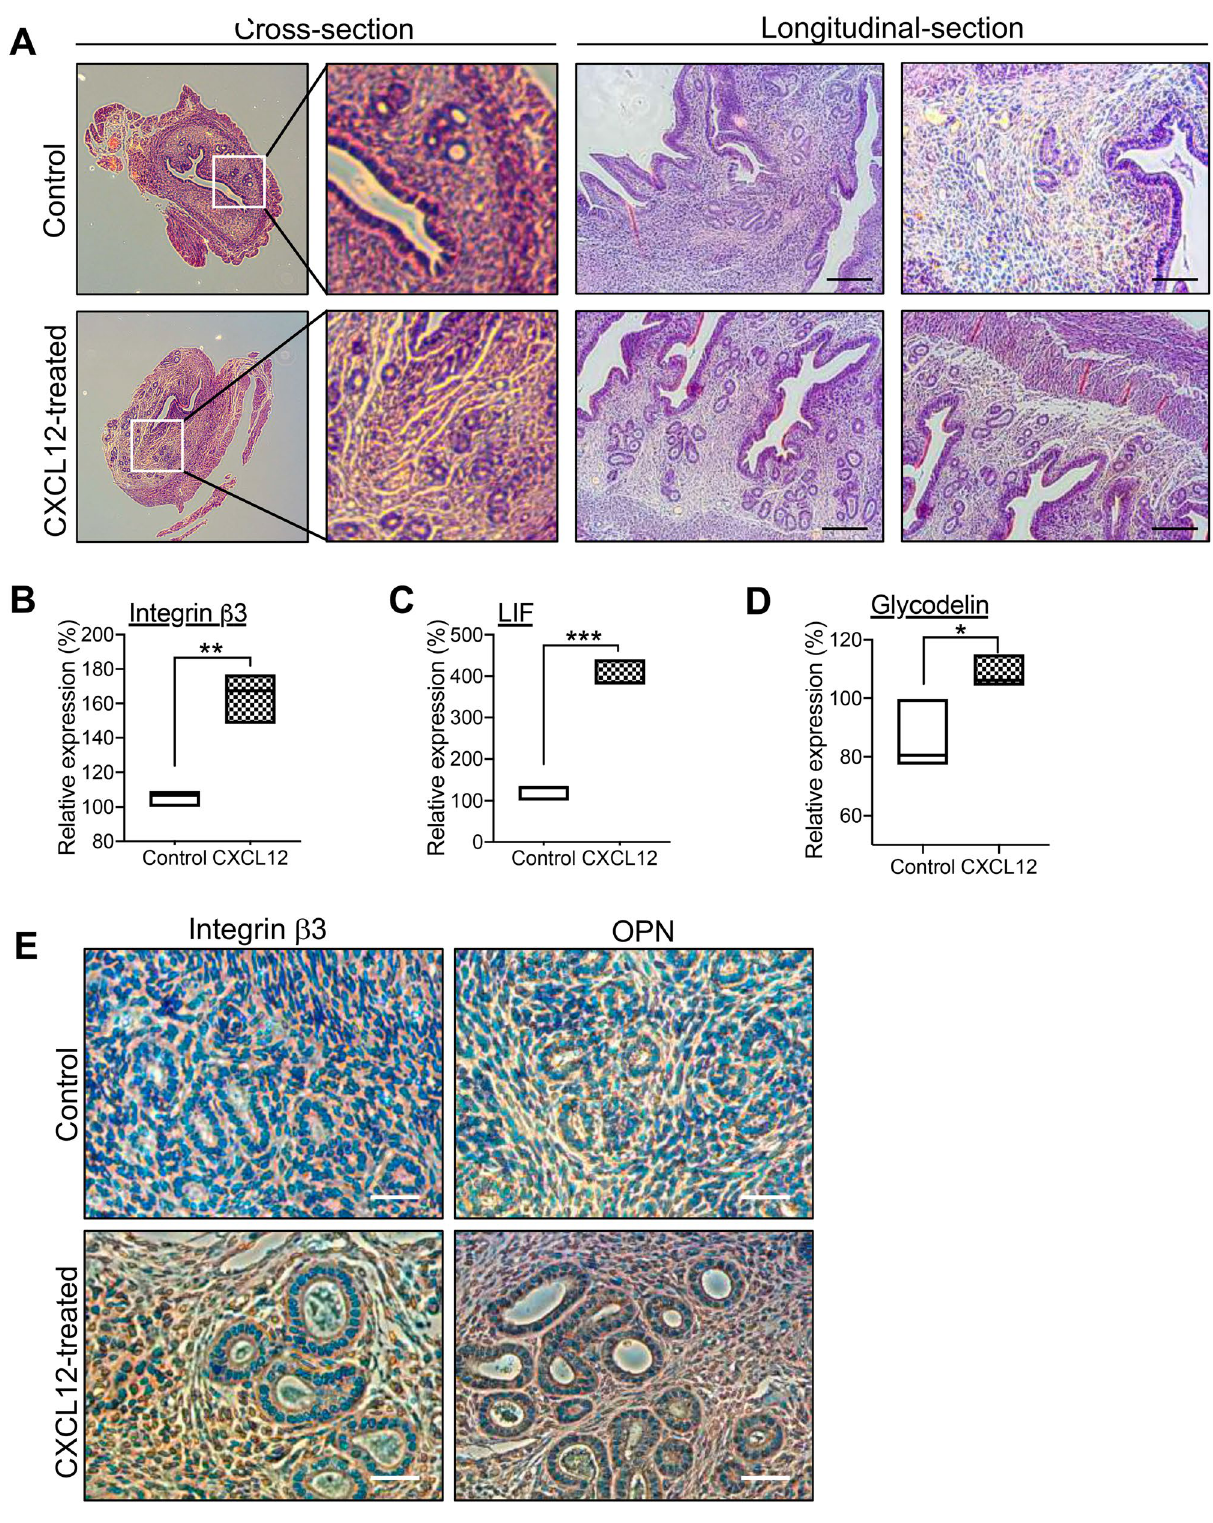
Figure 4. Increased endometrial receptivity with intra-uterine CXCL12 treatment. ( A ) H&E staining of cross- sectioned or longitudinally-sectioned mouse uterus harvested 8 days after CXCL12 treatment. Scale Bar; 150um. ( B-D ) QRT-PCR analysis of Itgb3, Lif, and Paep in CXCL12-treated uterus samples compared to controls. ( E ) Immunohistochemical staining of integrin β3 and SPP1 in CXCL12-treated uterus samples compared to controls. Scale Bar;